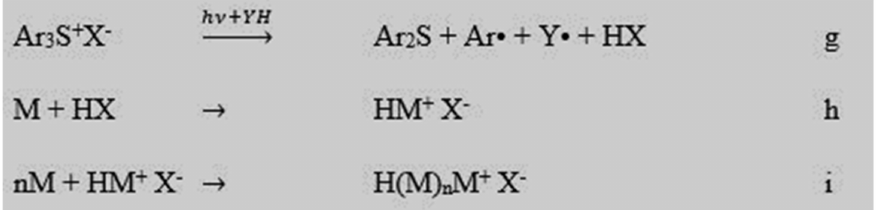
Figure 2. Cationic photocuring mechanism. Reprinted (adapted) with permission from Crivello, J V (General Electric), “The Photoinitiated Cationic Polymerization of Epoxy Resins”. Copyright (1979) American Chemical